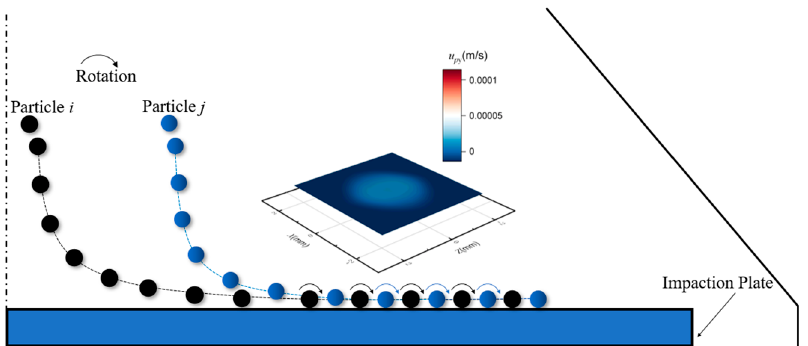
Figure 6. The schematic of particle trajectory above the impaction plate for “ring”.